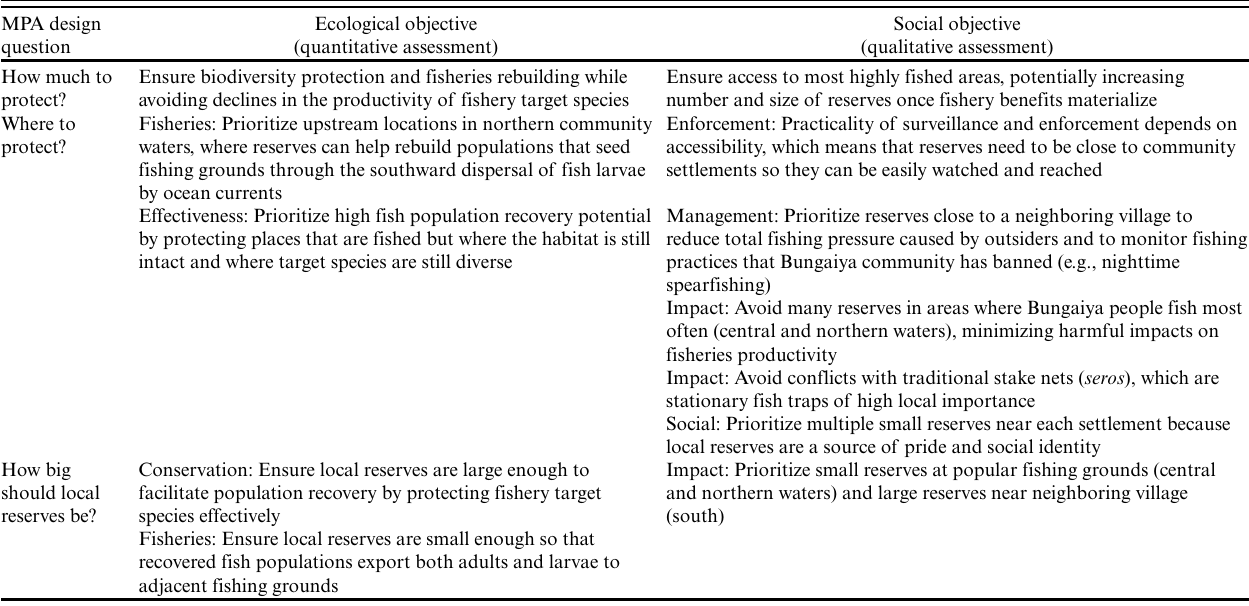
Table 3. Ecological and social objectives for community-based marine protected area (MPA) design in Bungaiya, Indonesia. MPA design question